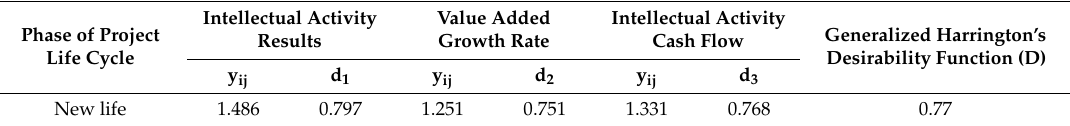
Table 7. An example of standard mark interpretation on the Harrington’s scale for Project 1 in accordance with the life cycle phase.